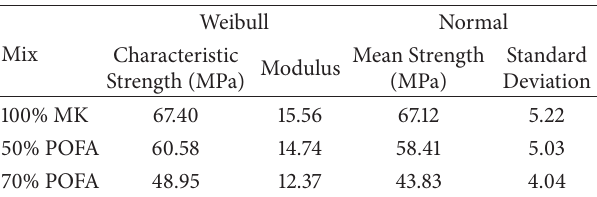
Table 5: Comparison of Weibull and Normal Distribution Parame- ters for Flexural Strength.